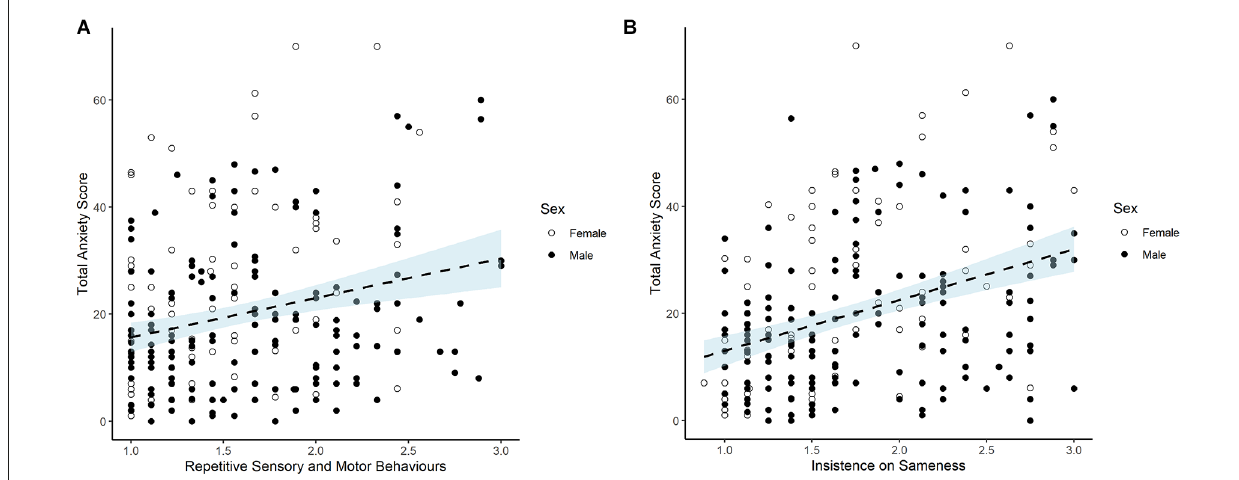
FIGURE1 (A) RBQ-2 RSMB subscale, Anxiety and Sex. Scatterplot showing relation between repetitive sensory and motor behaviors score (RSMB) and total anxiety score (measured by SCARED). Note: Each dot represents an individual participant. For RSMB subscale, scores of 1 (never/rarely) to 3 (marked/notable) are averaged across nine items. Note that there is no cut-off score but the 10th percentile and 1 standard deviation from the mean are 2.33 and 2.1 respectively. SCARED scores 0–2 for 41 items produce a Total score of 82. Note that scores of 25 or above represent a clinical anxiety cut off. (B) RBQ-2 IS subscale, Anxiety and Sex. Scatterplot showing relation between insistence on sameness score (IS) and total anxiety score (measured by SCARED). Note: Each dot represents an individual participant. For IS subscale, scores of 1 (never/rarely) to 3 (marked/notable) are averaged across eight items. Note that there is no cut-off score but the 10th percentile and 1 standard deviation from the mean are 2.74 and 2.33 respectively. SCARED scores 0–2 for 41 items produce a Total score of 82. Note that scores of 25 or above represent a clinical anxiety cut